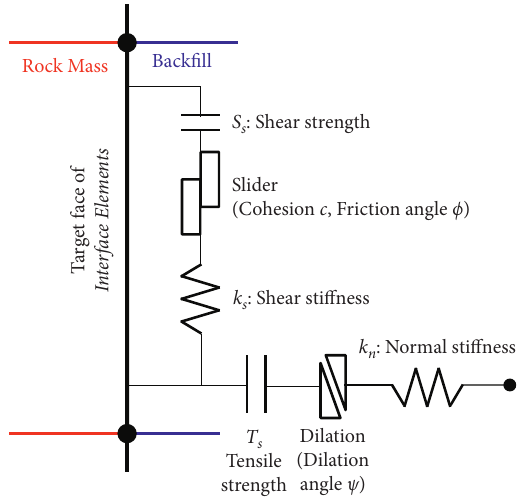
Figure 1: Schematic diagram for interface elements between backfill and rock in